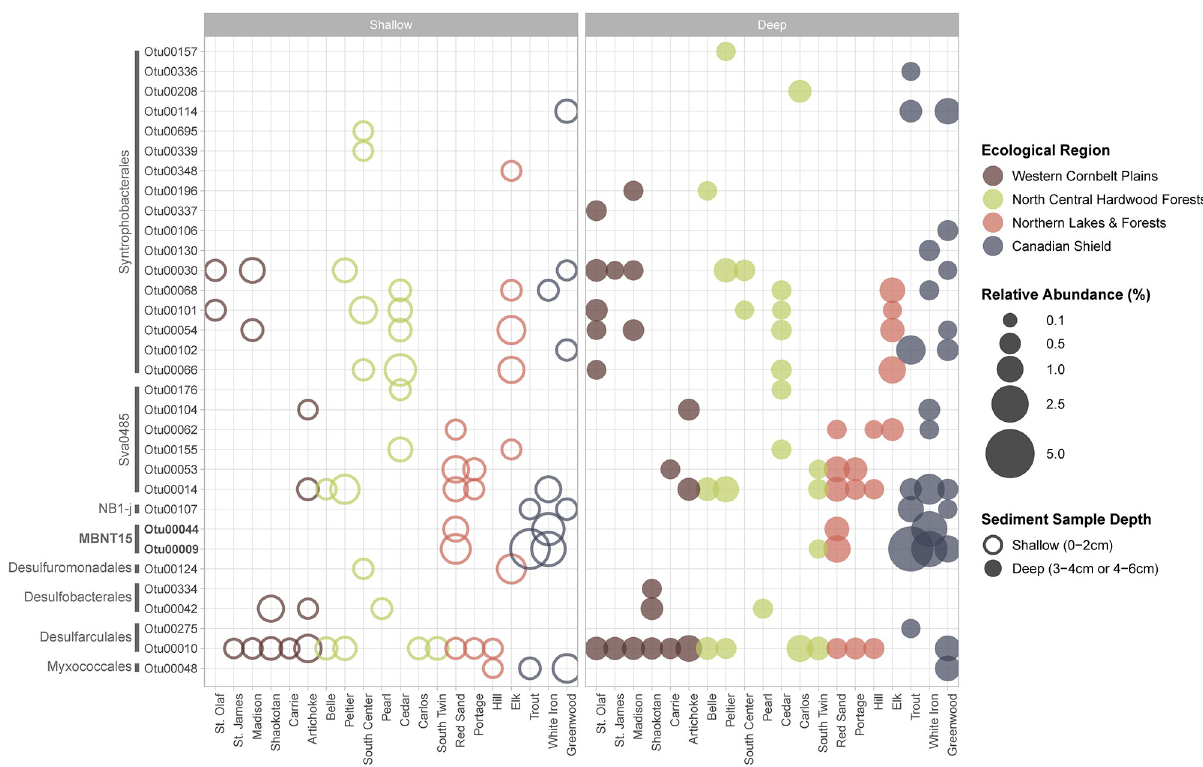
Fig 5. Deltaproteobacteria abundance across samples. Abundance comparison of sediment deltaproteobacterial communities where shape indicates depth of samples, color ecological region, and size the relative abundance in percent. Bars along the left group the OTUs by order. OTUs were selected if they comprised > 0.05% of the total relative abundance of the sample. The OTUs bolded are mentioned in the text.